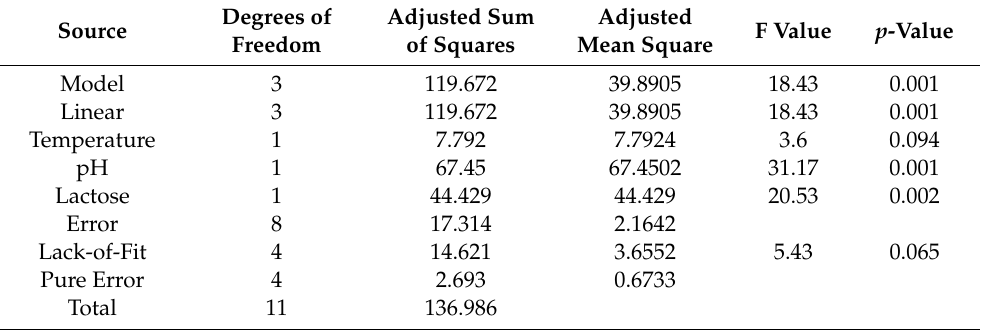
Table 7. ANOVA for the response surface quadratic model from Plackett–Burman design (for specific enzyme activity).